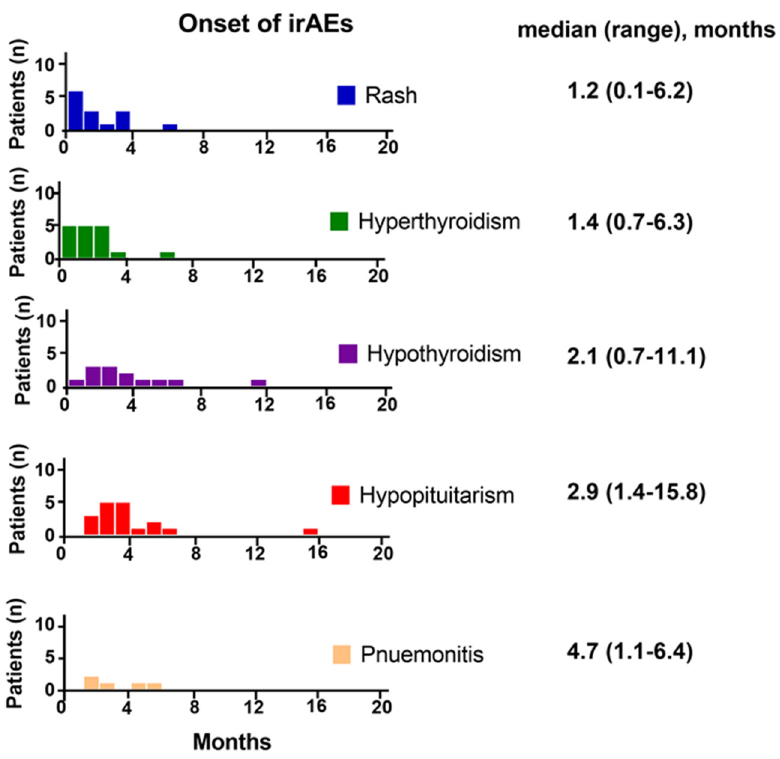
Figure 2. Onset times of each irAE. Blue, green, purple, red, and orange bars indicate the number of incidences of rash, hyperthyroidism, primary hypothyroidism, hypopituitarism, and pneumonitis, respectively, in each month following nivolumab plus ipilimumab initiation.